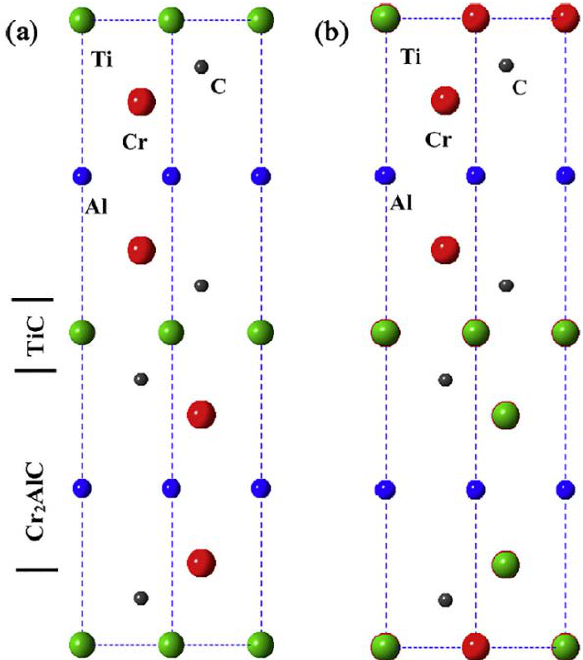
Figure 4. Crystal structure of (Cr 2/3 Ti 1/3 ) 3 AlC 2 with ordered M-positions ( a ) and randomly arranged atoms in M positions ( b ), projected onto the plane [1210]. Reprinted with permission from [32] 2014 Elsevier.